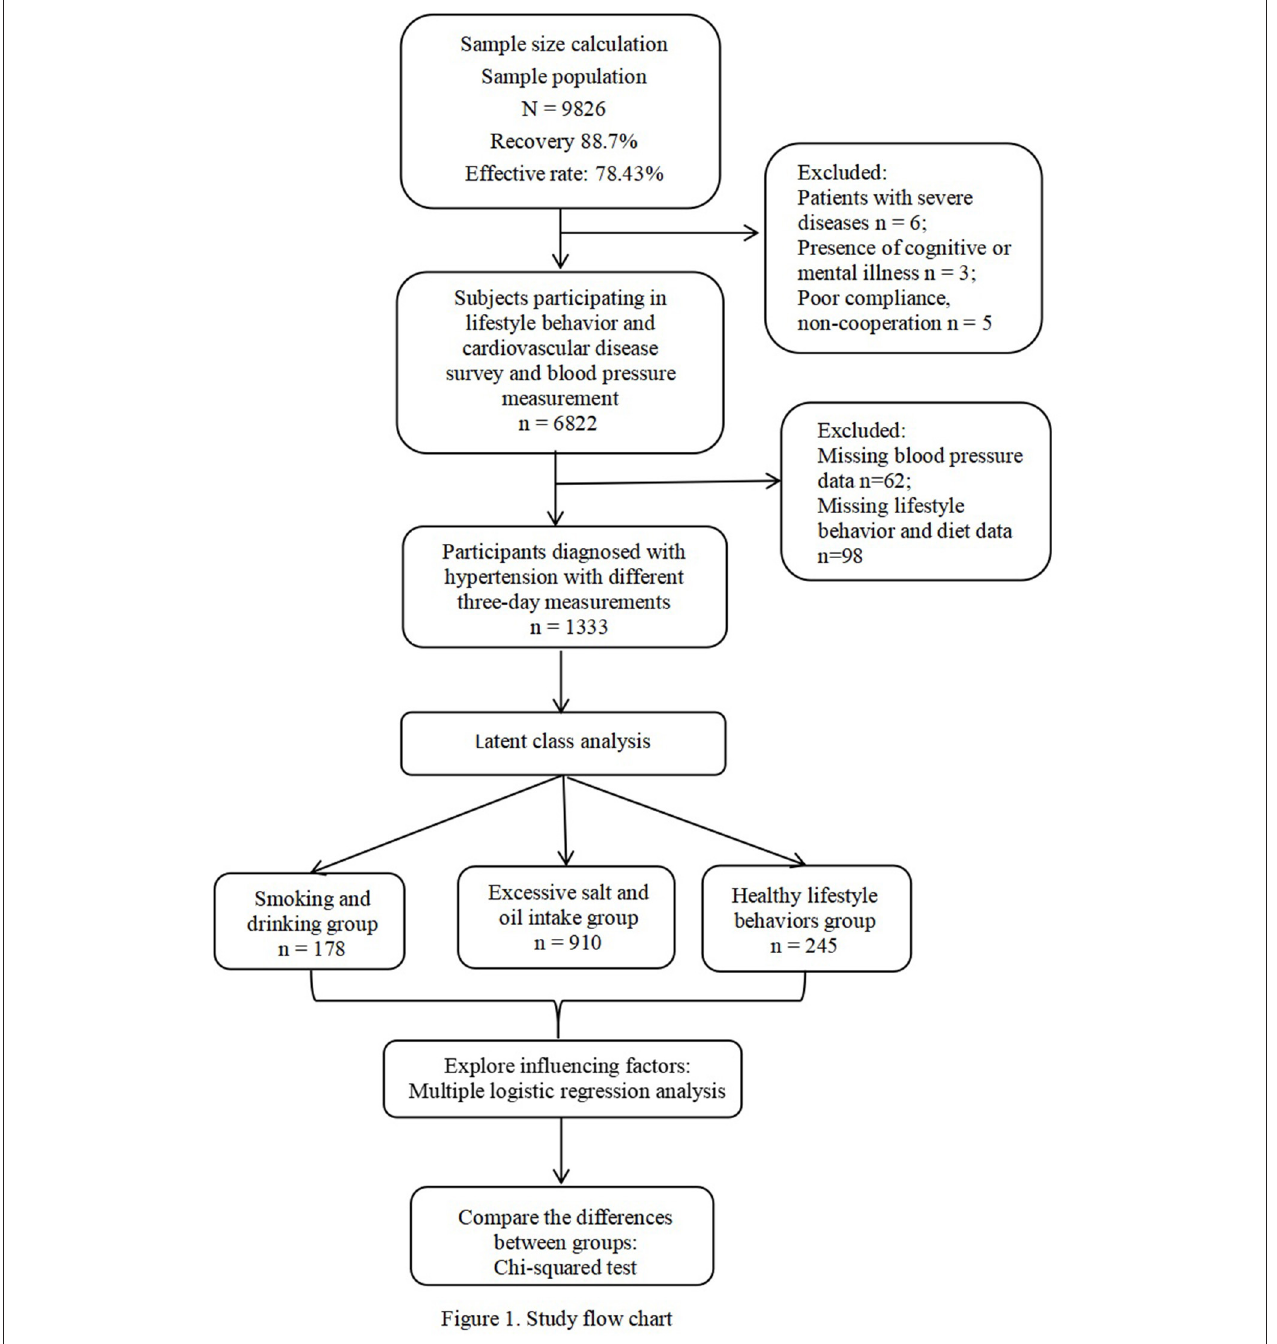
FIGURE 2 | Latent class analysis profile pilot: the conditional probability distribution of nine lifestyle behavior.